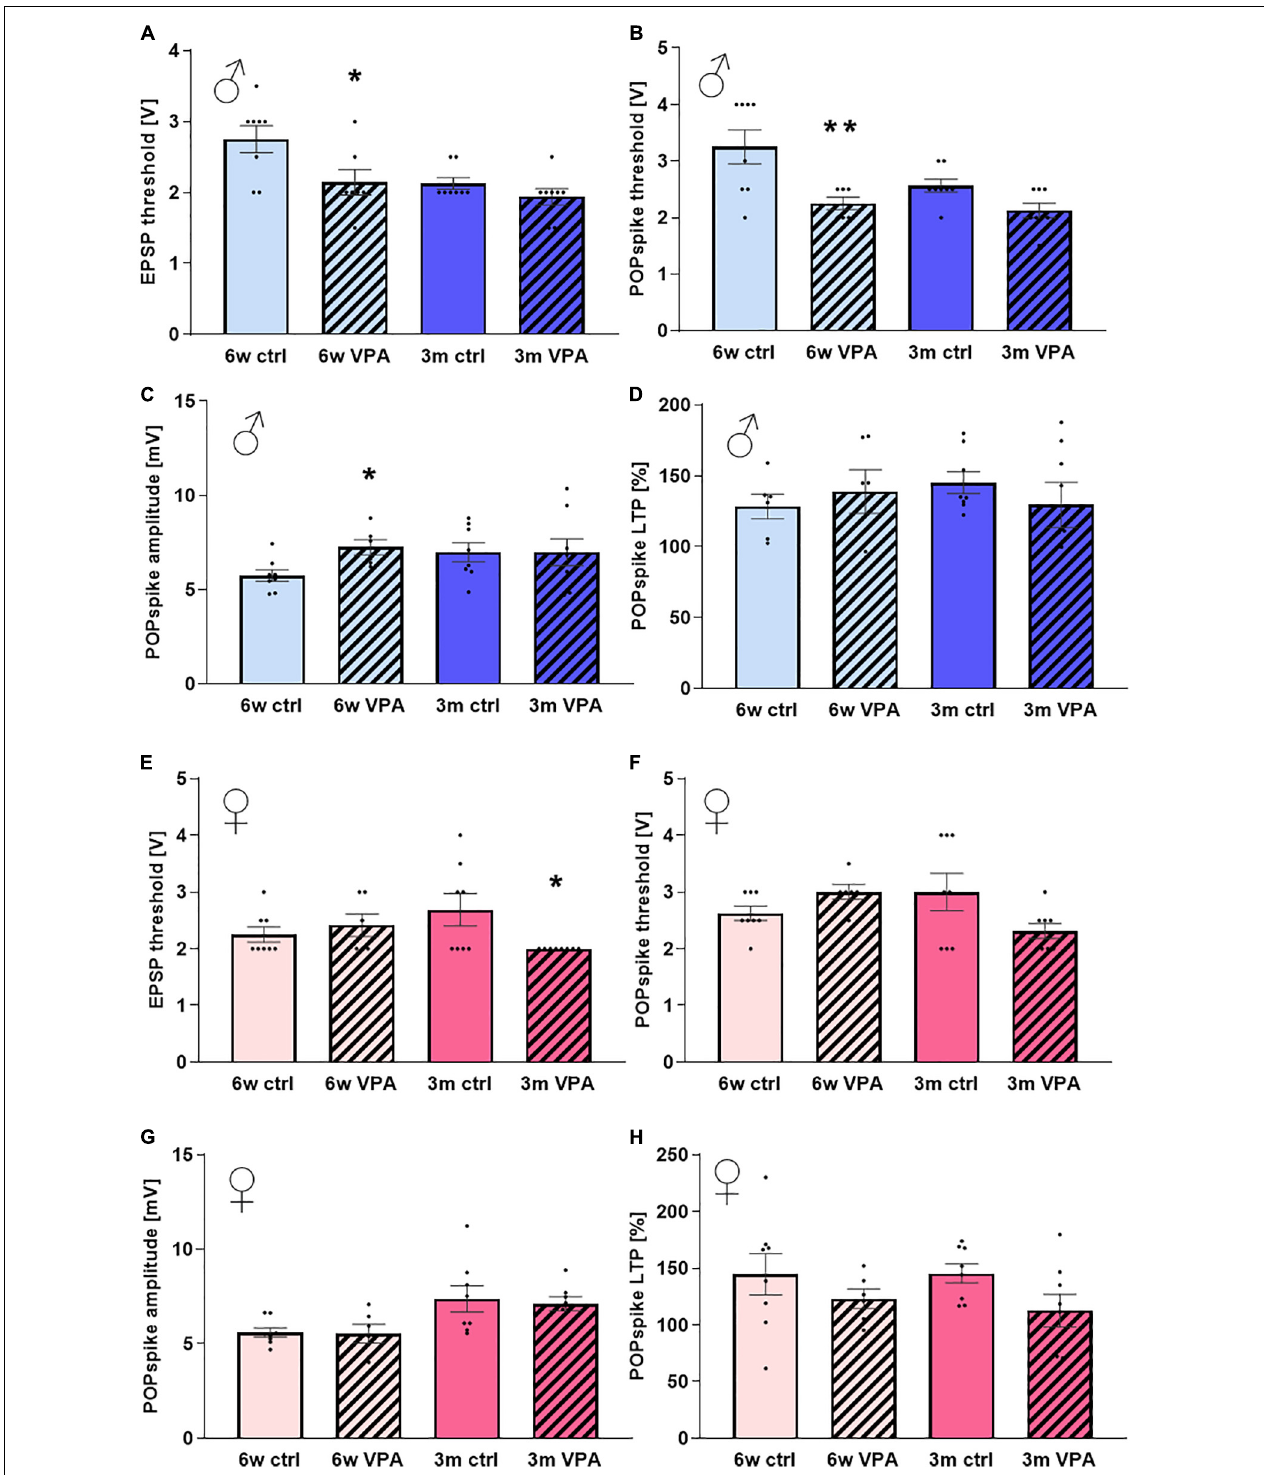
FIGURE 5 | The effects of prenatal VPA-treatment on hippocampal neuronal networks of 6-week-old and 3-month-old rats of both sexes. (A) The average threshold of evoked field EPSPs and (B) POPspikes, (C) the average amplitude of POPspikes and (D) the average change in POPspike amplitude 30 min after LTP-induction compared to the baseline in males. (E) The average threshold of evoked EPSPs and (F) POPspikes, (G) the average amplitude of POPspikes and (H) the average change in POPspike amplitude 30 min after LTP-induction compared to the baseline in females. Data are expressed as mean and S.E.M. Statistical analysis: one-way ANOVA; * significant difference compared to control group; * p < 0.1; ** p < 0.005.